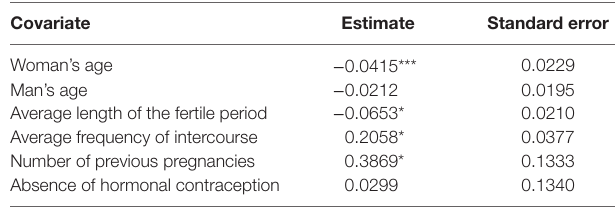
Table 7 | Estimates of the regression coefficients affecting the conditional probability of clinical pregnancy given the latent process under the LM model with two latent states (*significant at 1%, ***significant at